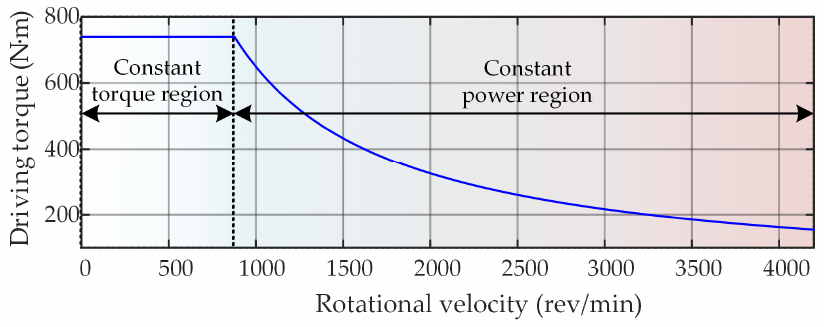
Figure 7. Mechanical characteristics of traction motors.